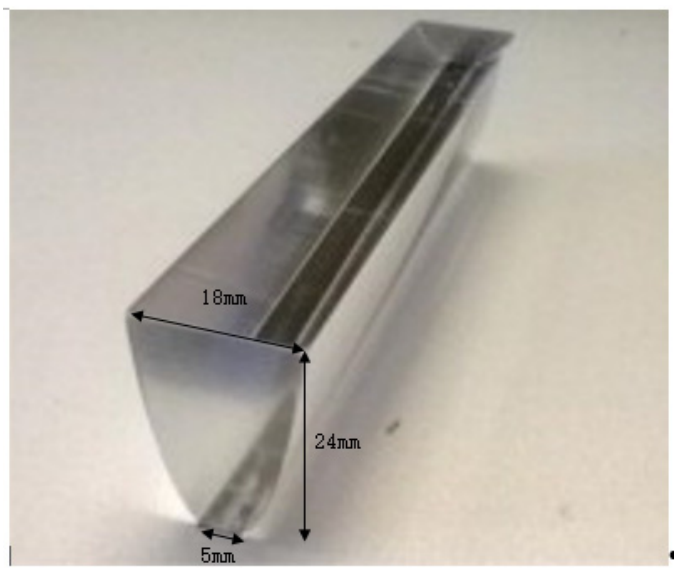
Figure 2. Photo of a miniature solid CPC [15].